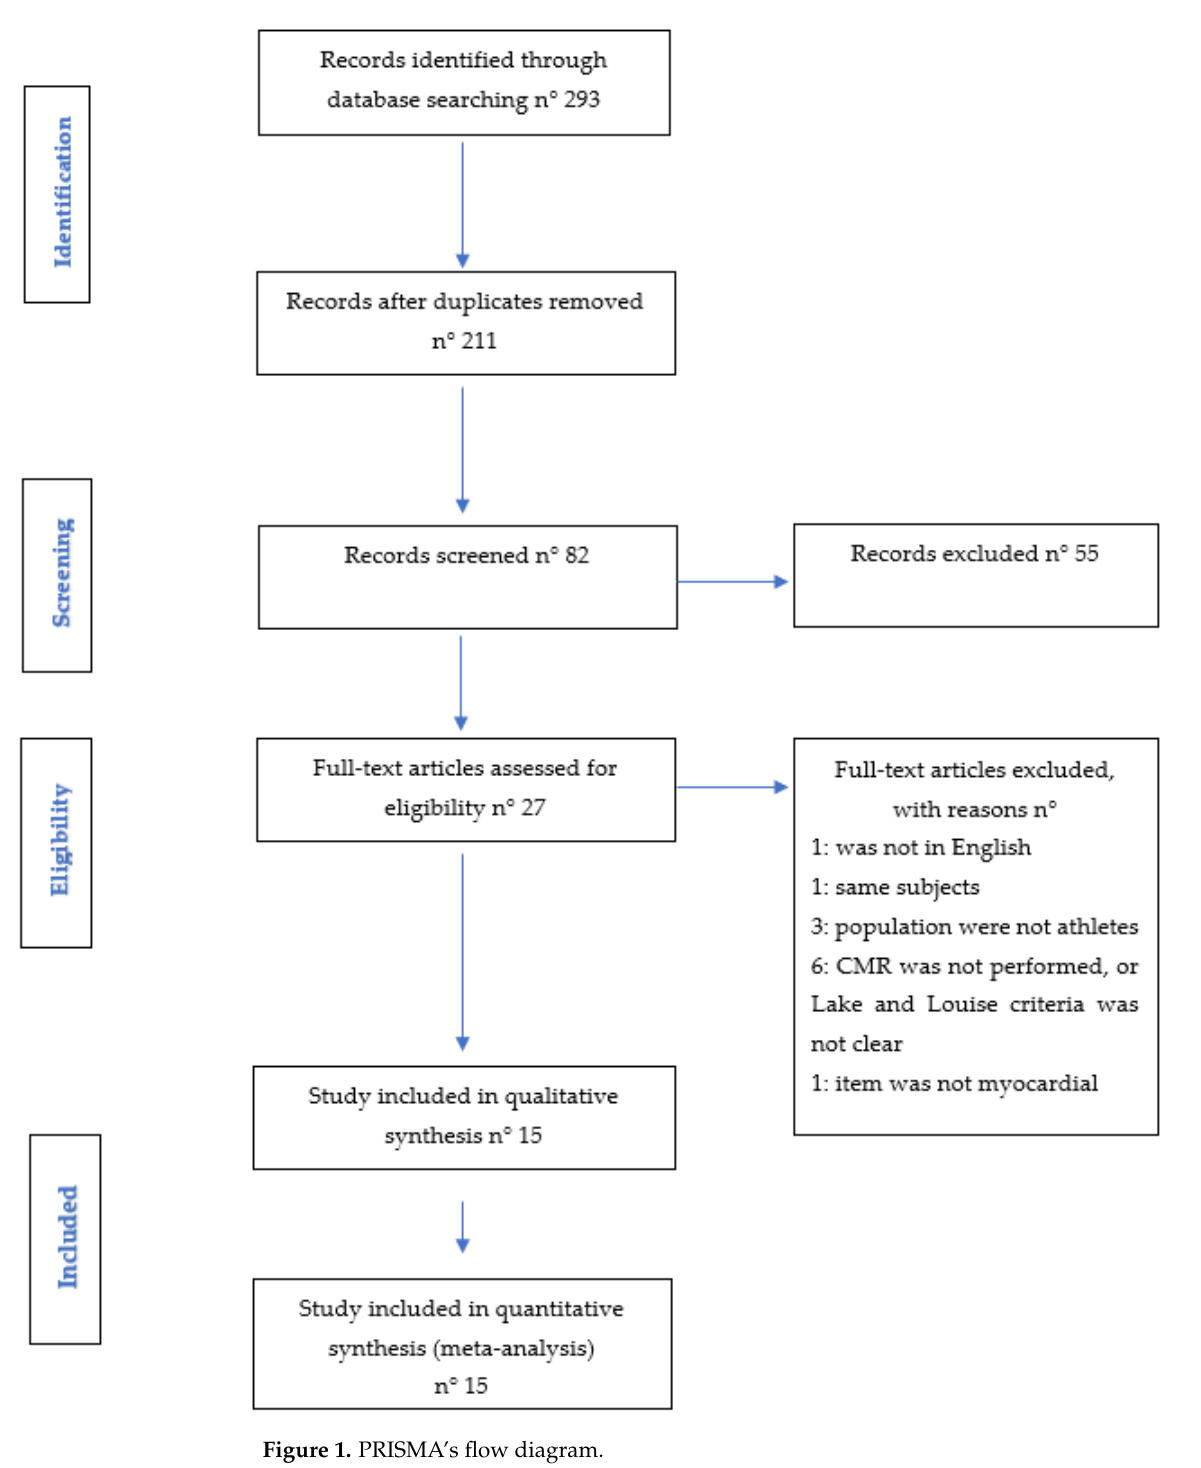
Figure 1. PRISMA’s flow diagram.